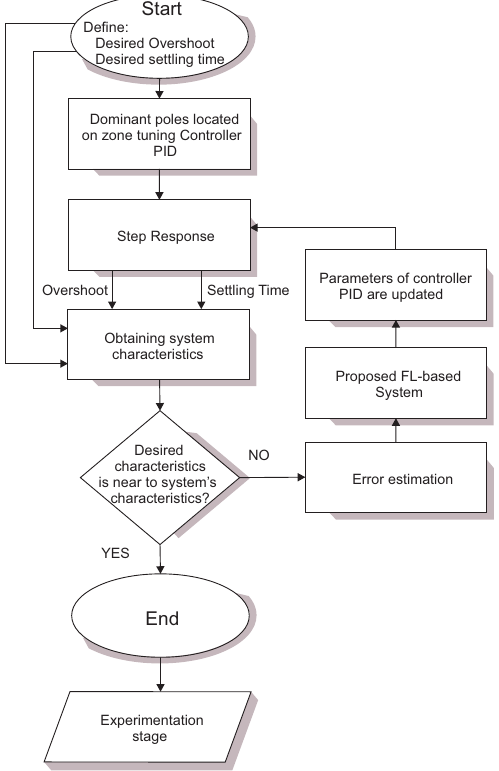
Figure 2. Flowchart of the proposed tuning method for PID